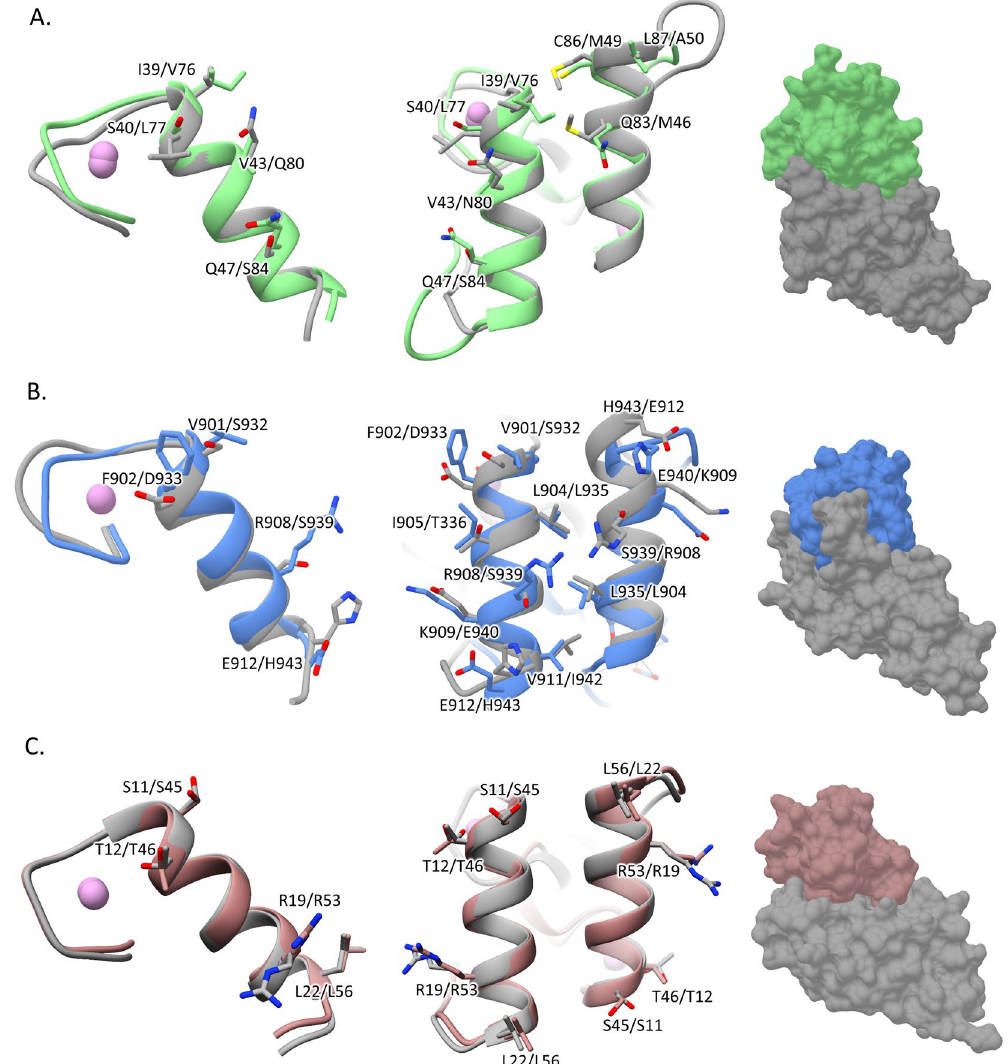
Figure 4. Significant differences between the two cohesin-binding interfaces do not allow the dual-binding mode of dockerins from R . flavefaciens . ( A ) R . flavefaciens Group1 Doc. ( B ) R . flavefaciens Group3 Doc. ( C ) C . thermocellum Doc. The first image of each panel shows an overlay of the N-terminal and C-terminal dockerin repeats. In all cases it is apparent that both repeats are similar at the main-chain atoms but only the C . thermocellum Doc ( C ) shows conservation in the side chains, allowing the dual-binding mode. The middle image of each panel shows a comparison of the two putative binding surfaces by overlaying the dockerins with a version of themselves rotated by 180° (in grey) and shows a lack of conservation in the key contacting residues in both R . flavefaciens dockerins ( A , B ). Contrary to the C . thermocellum Doc ( A ), lack of internal symmetry in Doc1a and Doc3 and the involvement of the two helices in cohesin recognition suggest that they display a single cohesin-binding platform. The final image of each panel shows the molecular surface of the several complexes, with the cohesin in grey and the dockerin in green ( Rf Doc1a), blue ( Rf Doc3) or pink ( C . thermocellum